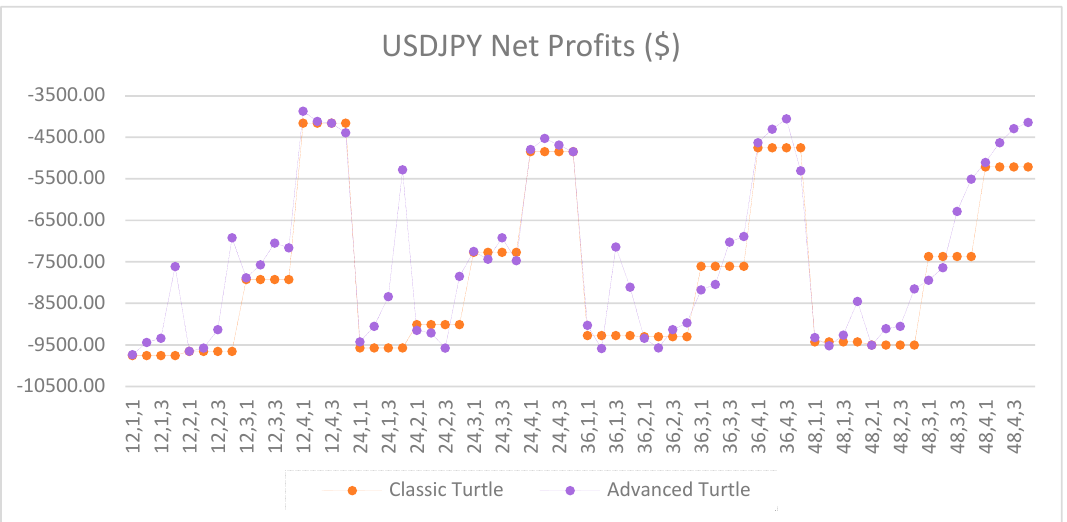
Figure A9. Net profits of USDJPY between the classic and the advanced Turtle systems for every combination of N, X, Y for the fast parameters (20, 40).